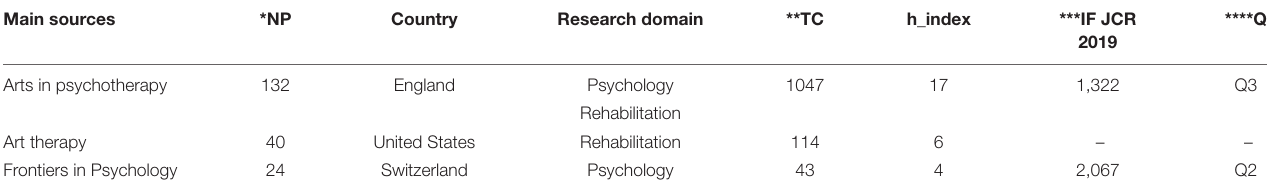
TABLE 3 | Journals with the highest production in art therapy